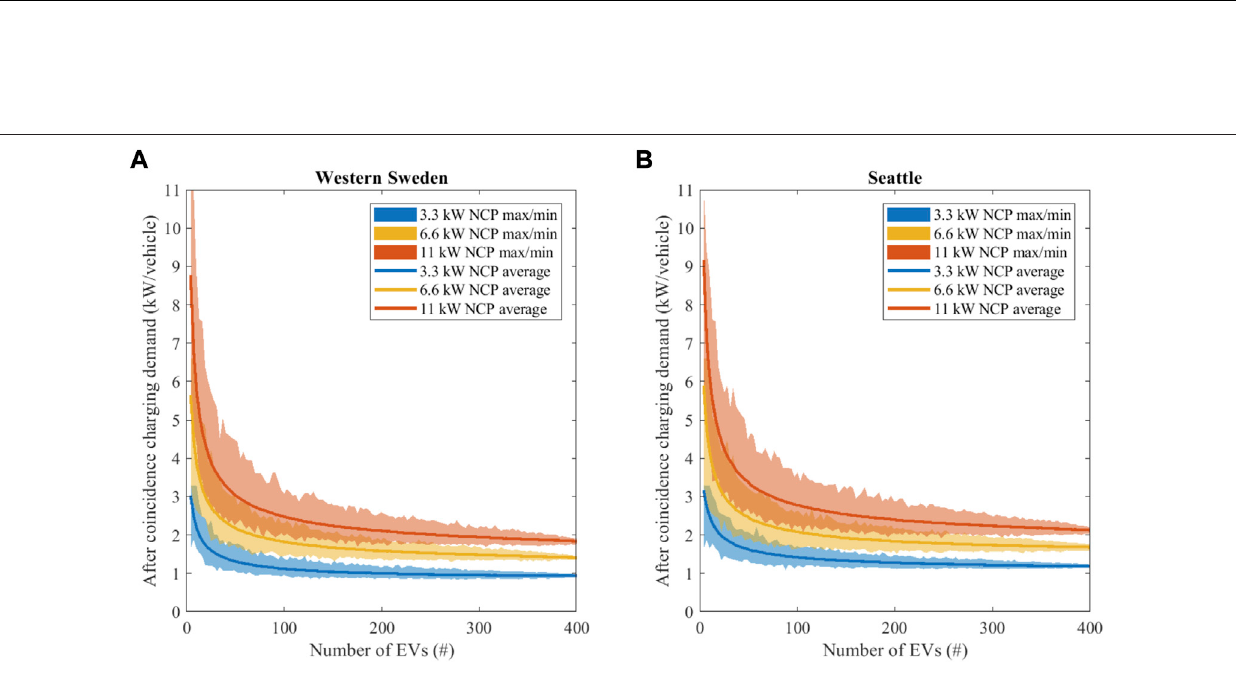
Frontiers in Energy Research |